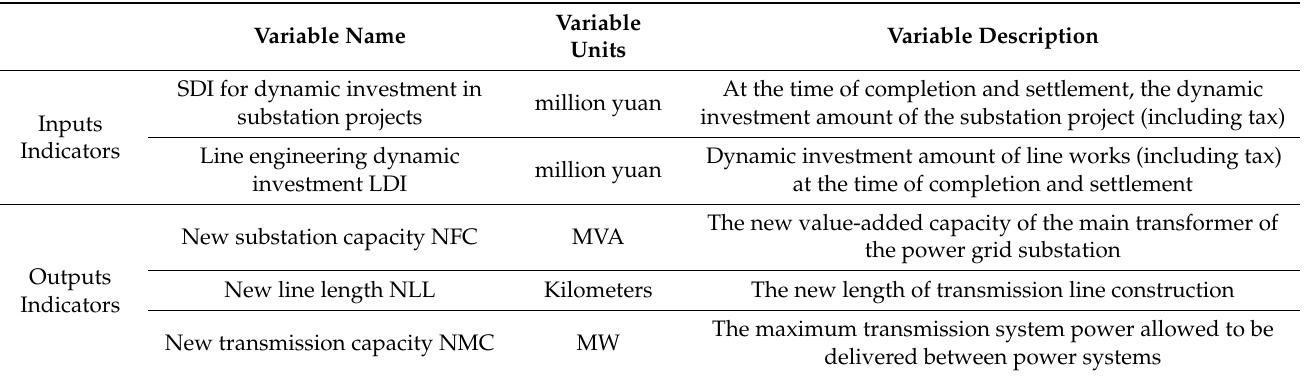
Table 2. Selection of input–output indicators.